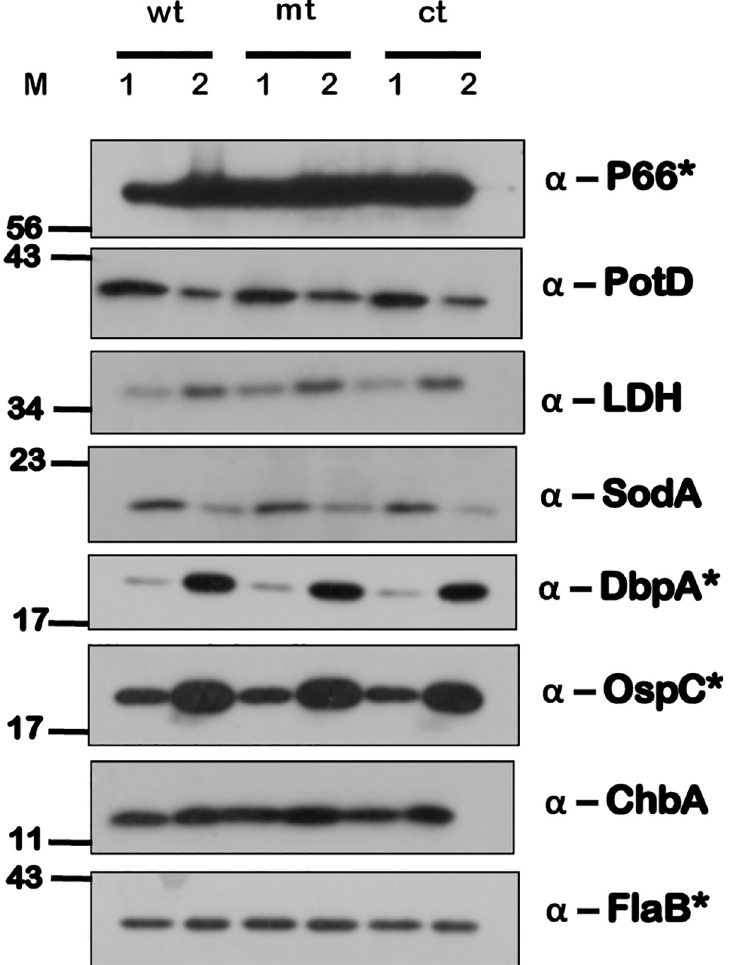
Fig 6. Levels of pathogenesis-related proteins in bpiP mutant. Total protein lysates of wt, mt, ct strains grown under conditions mimicking midgut of unfed tick (Lane 1, pH 7.6/ 23˚C) and shifted to conditions mimicking midgut of fed tick (Lane 2, pH 6.8/37˚C) were separated on a 12% SDS-PAGE gel, transferred to PVDF membrane and subjected to immunoblot analysis using antisera against various borrelial proteins indicated to the right of each blot. Goat anti- mouse HRPO-conjugated antibodies were used as secondary antibodies and blots were developed using ECL system. Molecular masses in kilo Daltons (kDa) are indicated to the left. ( � indicate protein samples diluted 1:10 due to quality of the antibody